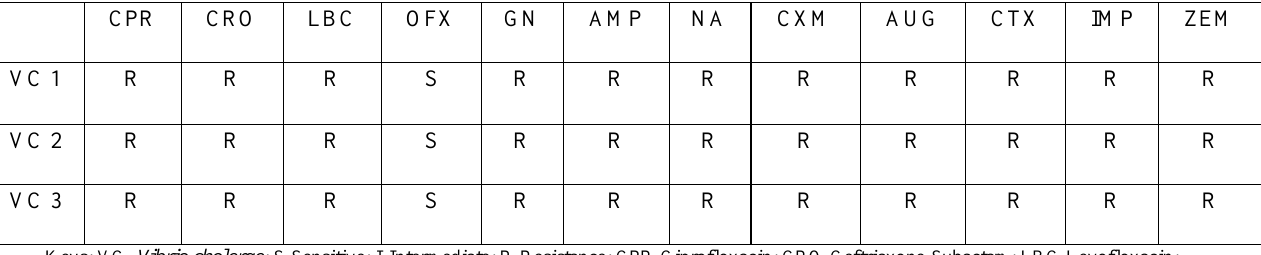
Keys: VC- Vibrio cholerae ; S-Sensitive; I-Intermediate; R-Resistance; CPR-Ciprofloxacin; CRO-Ceftriaxone-Subactam; LBC-Levofloxacin; OFX-Ofloxacin; GN-Gentamycin; AMP-Ampicillin; NA-Nalidixic Acid; CXM-Cefuroxime; AUG-Augmentin; CTX-Cefotaxime; IMP Imipenem;